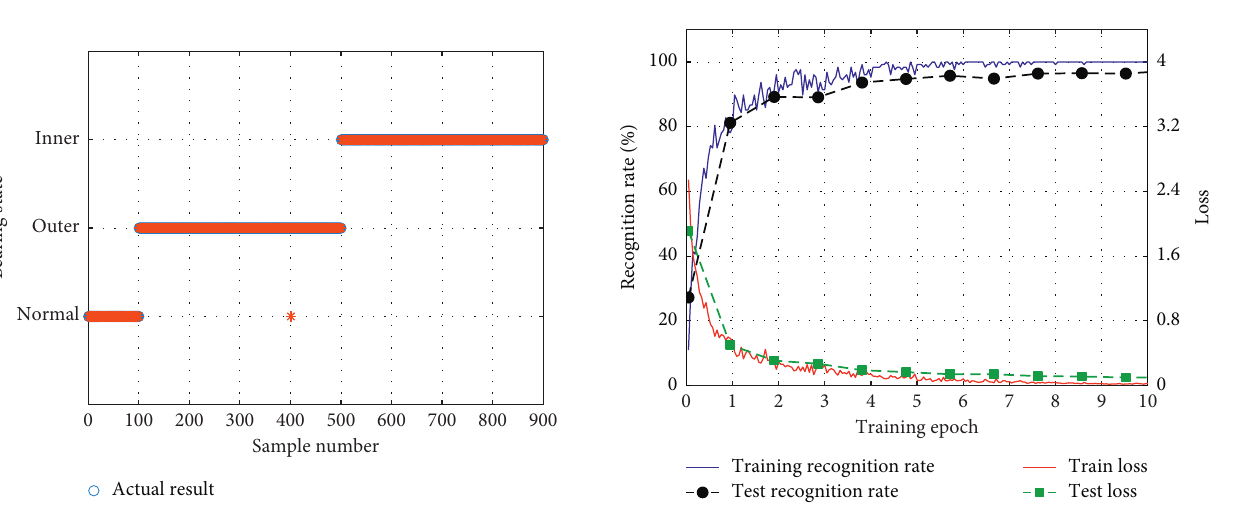
Figure 18: Training and verification process of degradation identification